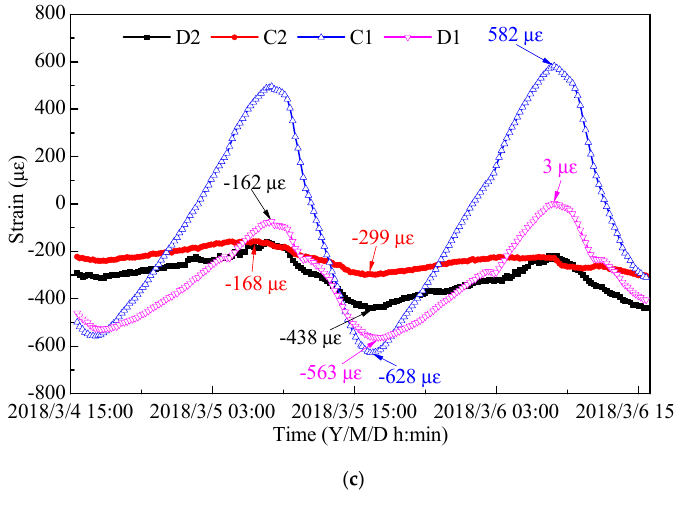
Figure 8. Time history curves of ( a ) the air temperature; ( b ) the induced strain in the middle of the base plate; and ( c ) the induced strain near the expansion joint.